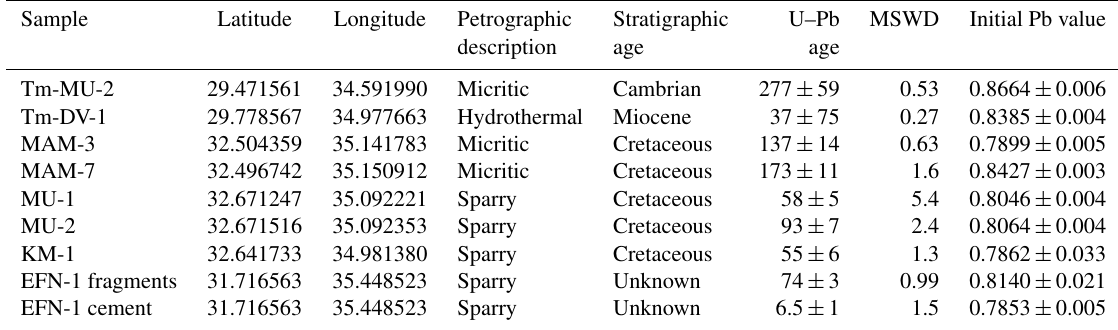
Table 1. Sample description, stratigraphic age, and their corresponding LA results. Sample